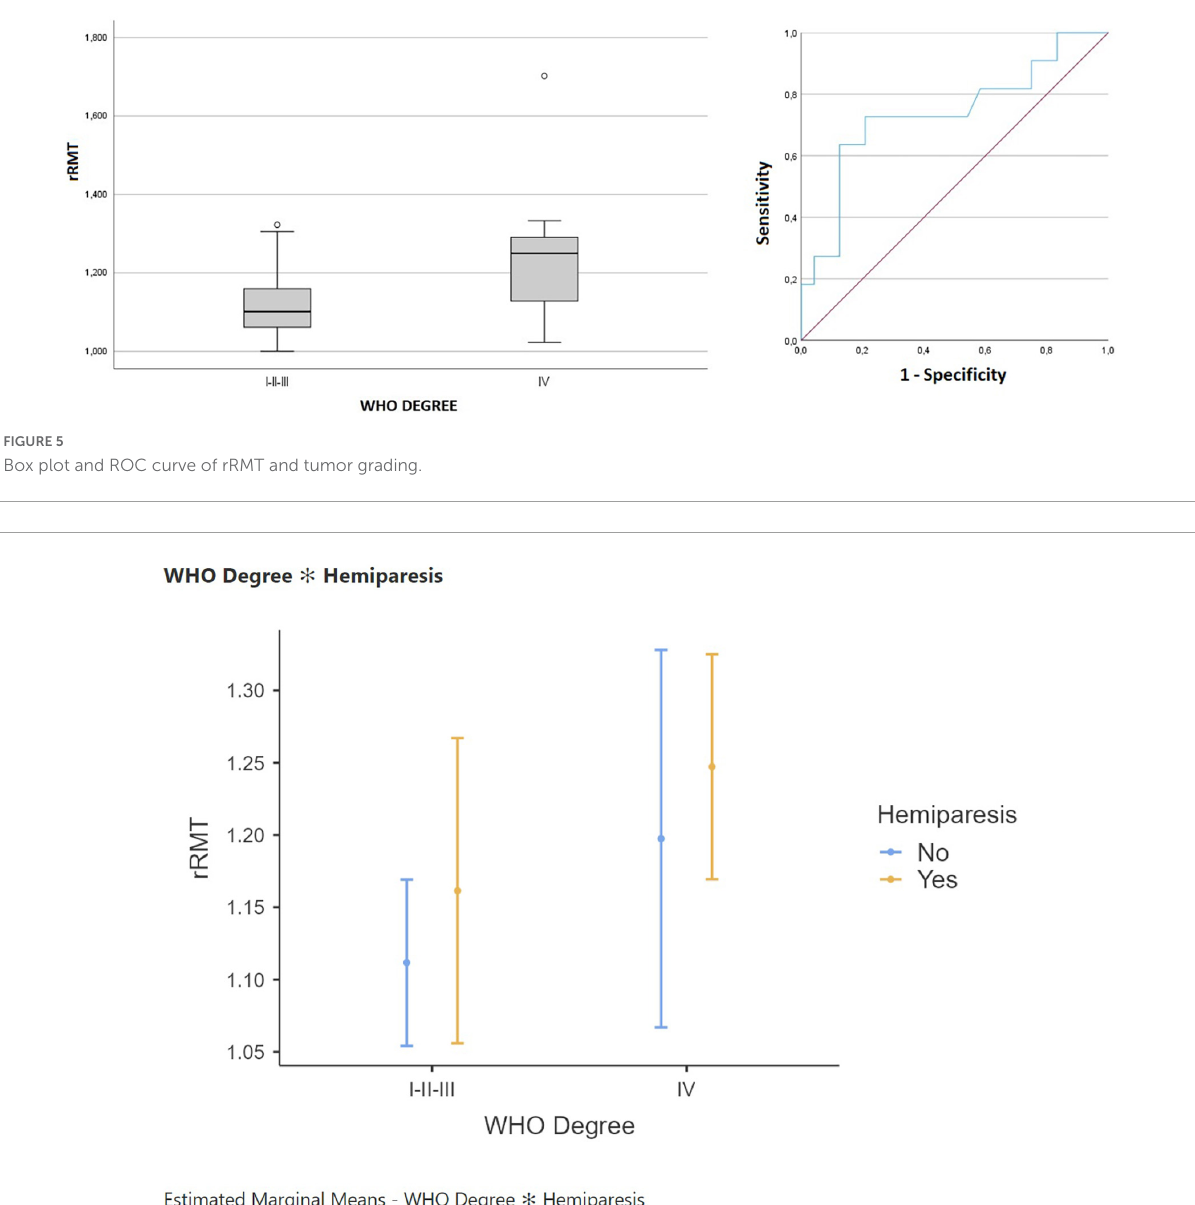
higher in grade IV tumors compared to grades I, II and III ( p = 0.025, Figure 5 ). A ROC analysis estimation determined an AUC of 0.737 with a threshold value of 1.169 rRMT value as cutoff for grade IV HGG. The analysis of independent factors to evaluate hemiparesis demonstrated a milder tendency of higher rRMT